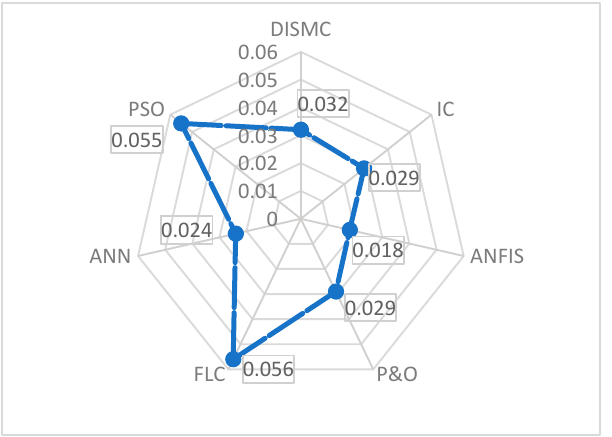
Figure 15. Relative errors of MPPTs algorithms under steady-state weather conditions: Test 1.